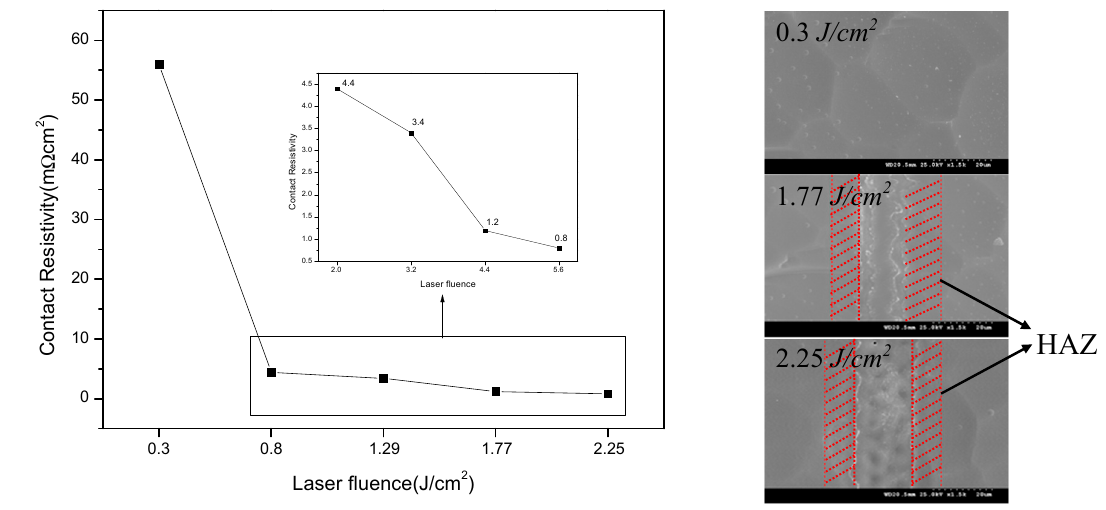
Figure 7. Contact resistivity versus the laser fluence and surface image of the Si wafer at different laser fluencies.